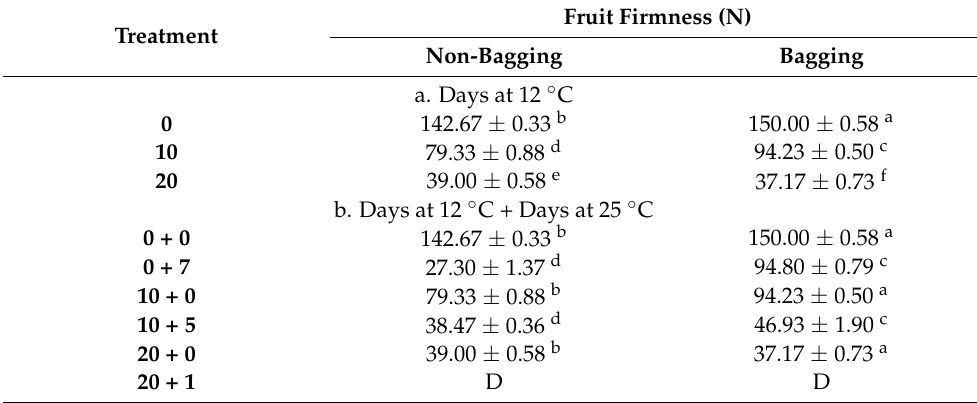
Table 1. Effect of on-tree fruit bagging treatments on mango fruit firmness during cold storage intervals and under ambient conditions. Values are means of triplicates ± SD. Different letters in superscripts indicate significant differences according to LSD test at p ≤ 0.05. D, decayed fruit hence no tests were